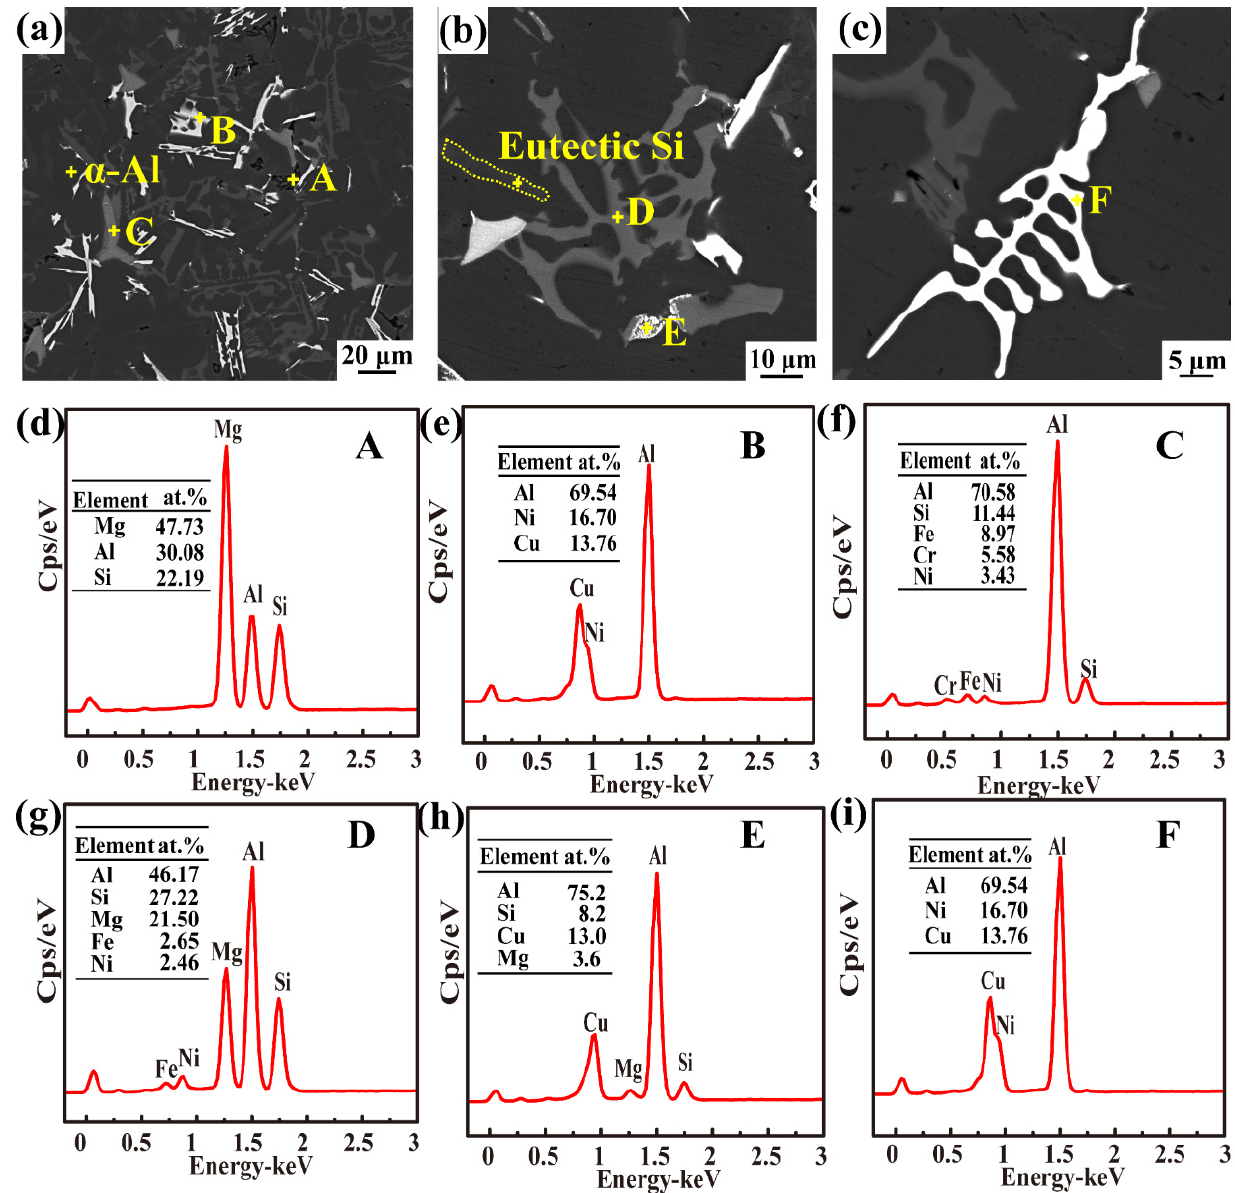
Figure 6. SEM morphology and EDS analysis of as-cast Al-Si alloy: ( a – c ) SEM morphologies, ( d – i ) EDS analysis result of Point A–F in ( a – c ).